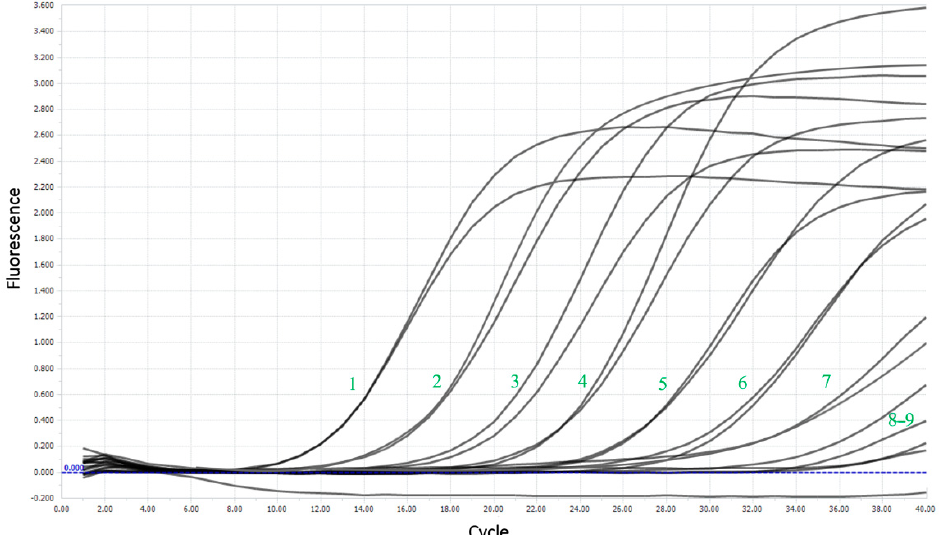
Figure 5. Amplification curves for a sensitivity test using the example of a series of dilutions of plasmid DNA. The numbers represent the dilution number.